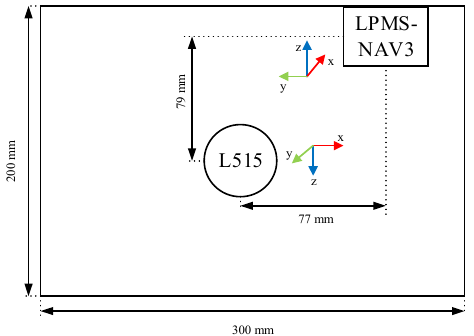
Figure 2. 2D position of devices and their coordinates.